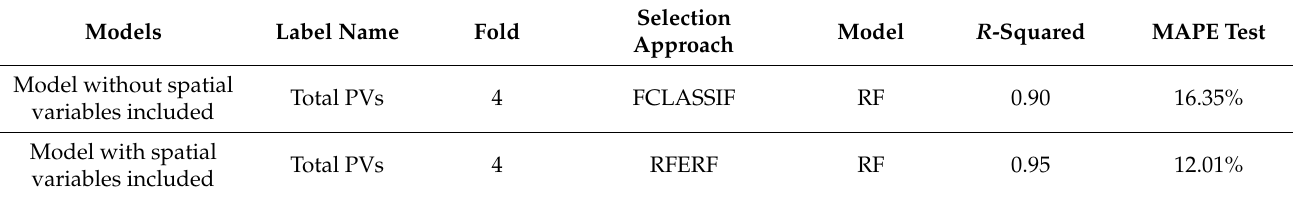
Table 6. Comparison of the RF models’ performance for the test data